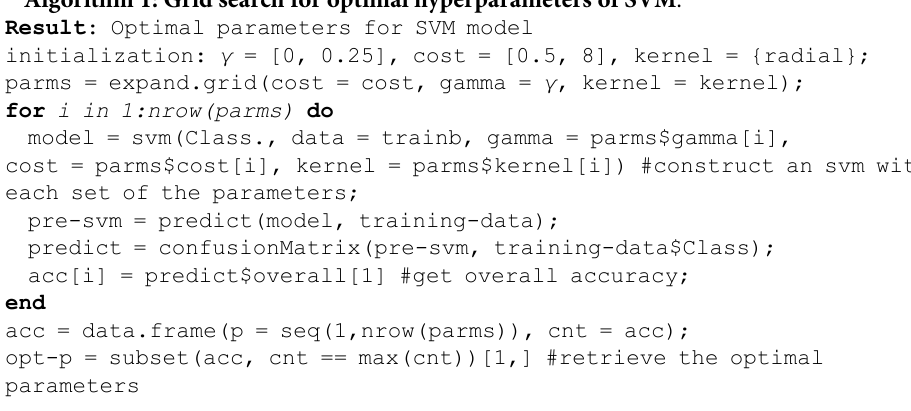
Algorithm 1: Grid search for optimal hyperparameters of SVM